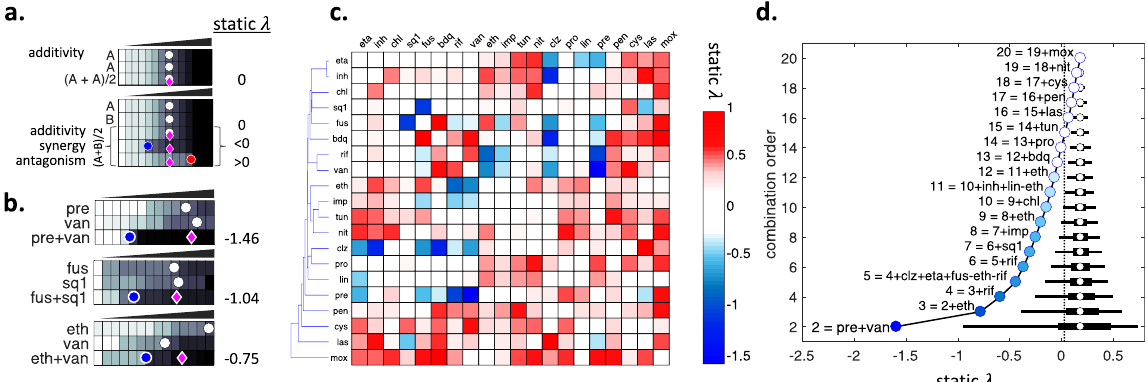
Figure 1. Static interactions among 20 antibiotics against M. tuberculosis . ( a ) Experimental setup for pairwise drug interaction measurements. M. tuberculosis cells are grown on increasing concentrations of single drugs and drug combinations. In each row, a circle marks the dose where a given inhibition level is observed (e.g. IC70 = 70% Inhibitory Concentration). The magenta diamonds indicate the well that is expected to achieve IC70 given the single drug IC70s. We scored each pairwise combination by static λ = log2(obs/exp). (top) By definition, a drug’s combination with itself is additive. In this case, the observed and expected IC70s will be identical and static λ = 0. (bottom) When two different drugs are combined, if observed IC70 is less or more than expected IC70, static λ scores are negative or positive, indicating synergy or antagonism. ( b ) Three examples of synergy observed among 190 tested pairwise interactions. The observed IC70 in the combinations pre + van, fus + sq1 and eth + van (blue circles) is strikingly less than the expected IC70 given single drug IC70s (magenta diamonds), resulting in negative static λ scores. ( c ) Hierarchical clustering of all interaction scores among 20 antibiotics are shown as a heatmap. Blue, white or red indicate synergy, additivity or antagonism, respectively. Among 190 pairs tested, 11 pairs had static λ < − 0.5. ( d) The effect of combination order (number of drugs in a combination) on the distribution of static interaction scores ( static λ ). Black horizontal line indicates the 95% and 50% percentiles for the interaction scores, and white circle shows the mean of all interaction scores. The best combination in each combination order is indicated with a circle on the left, named in reference to the best combination in the previous order. Vertical dashed line marks the static λ value estimated for the 3-order combination eth + inh + rif, the current Mtb